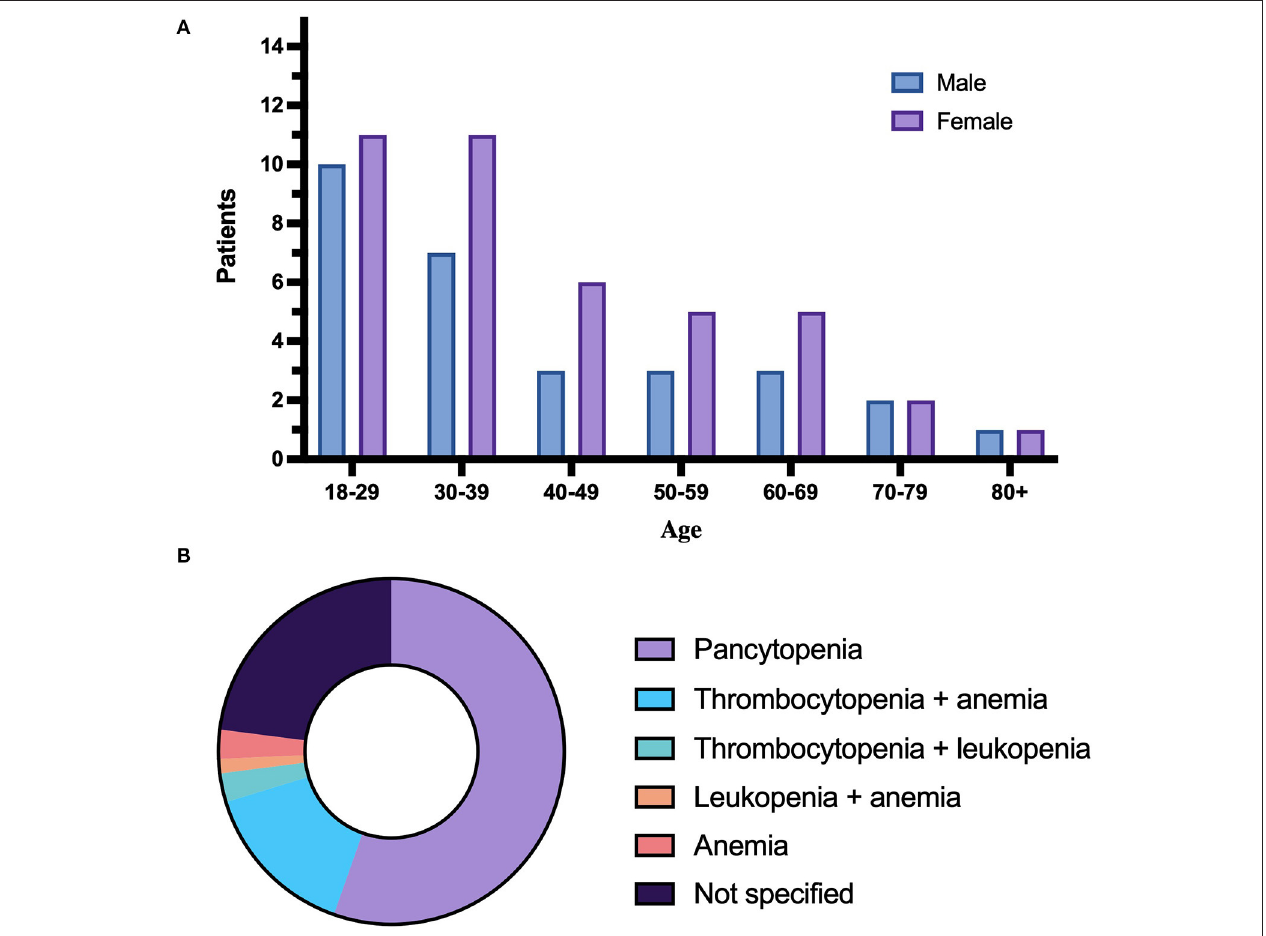
FIGURE 4 | Distribution of age, gender, and cytopenias. (A) Illustrates distribution of age and gender. Patients of unknown age/gender are not included. (B) Illustrates the distribution of degrees of